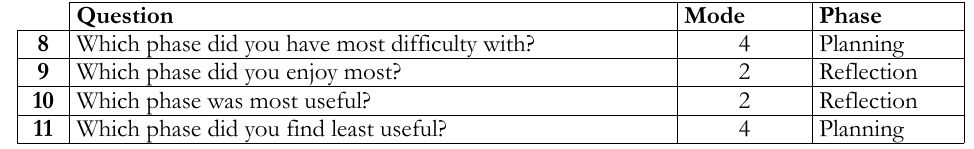
Table 2. End of project student perception survey part b